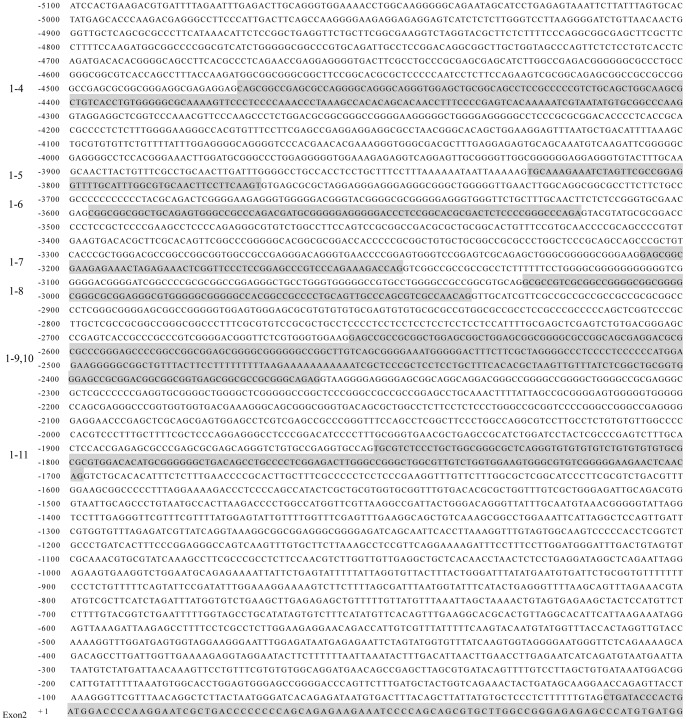
DNA sequence of the pig GR gene flanking the 5′-end of exon 2.Numbering is with respect to the translation start site within exon 2. The start of the porcine exon 2 is at −13 bp. Shaded sequences represent identified porcine alternative GR first exons.